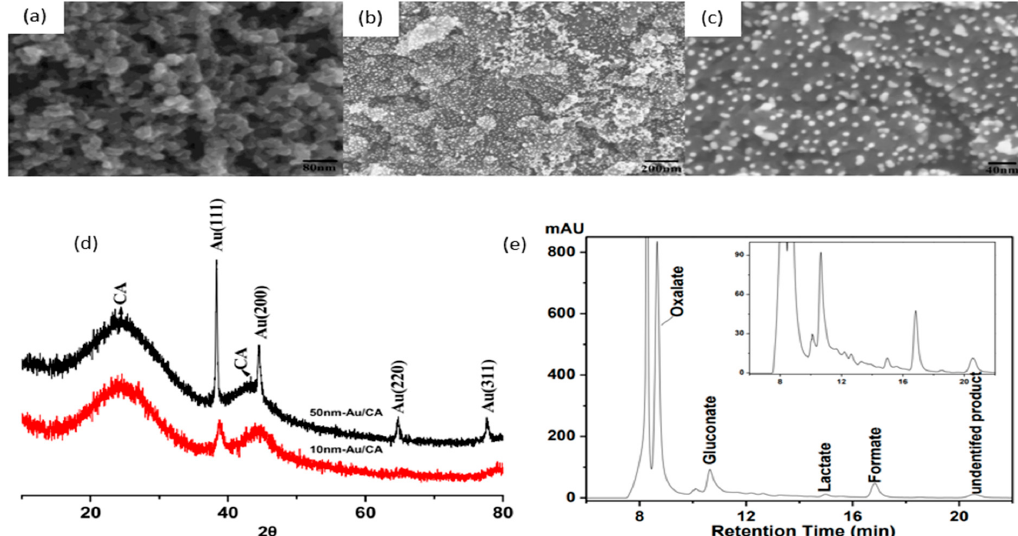
Figure 5. ( a ) SEM image of pretreated CA. ( b ) SEM of 10 nm Au/CA. ( c ) Magnified SEM of 10 nm Au/CA. ( d ) XRD results of 10 nm Au/CA and 50 nm Au/CA electrodes. ( e ) High performance liquid chromatography results of products using 10 nm Au/CA electrodes. Reprinted with permission from Ref [36]. Copyright 2015, Catalysis.